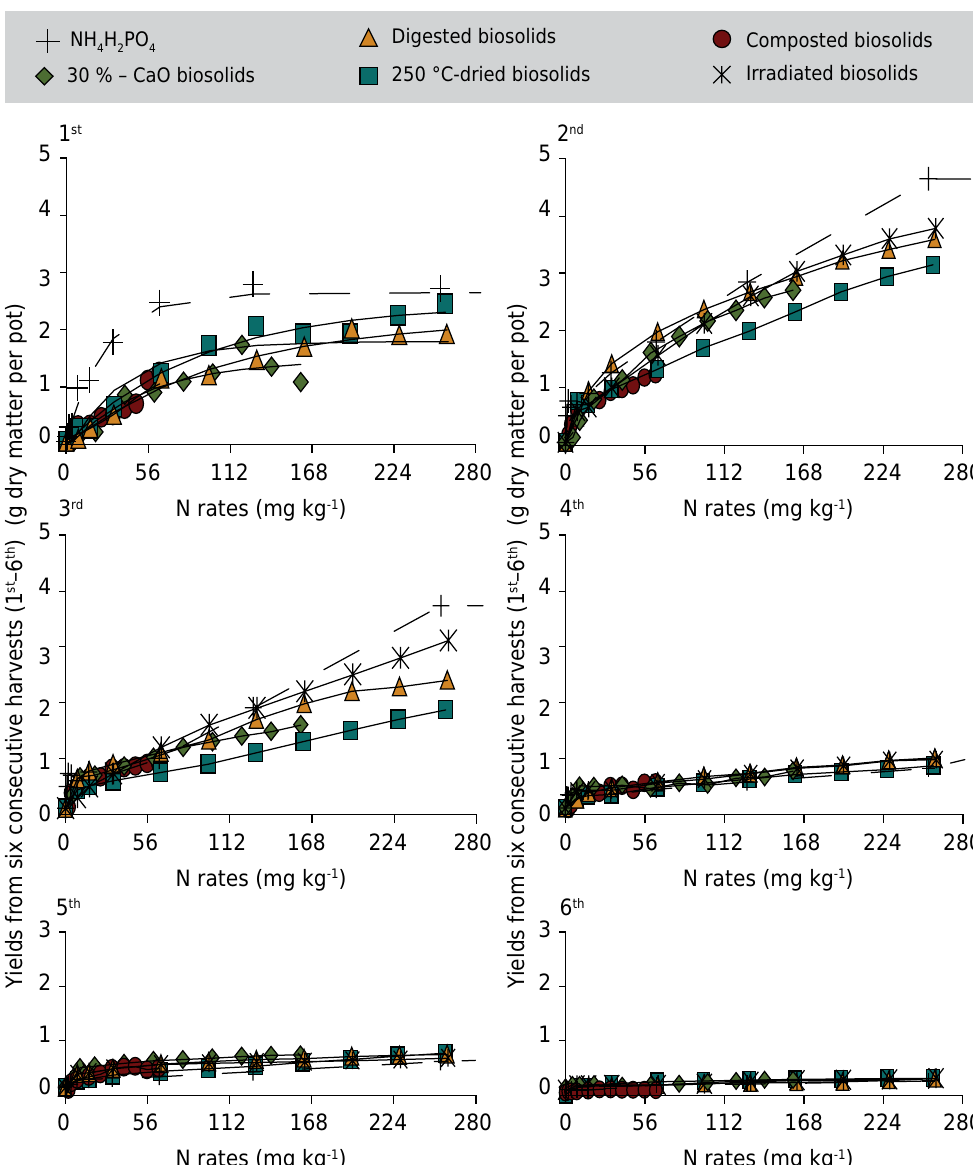
Figure 2. Yield responses to biosolids-N application and to NH 4 H 2 PO 4 + basal application in